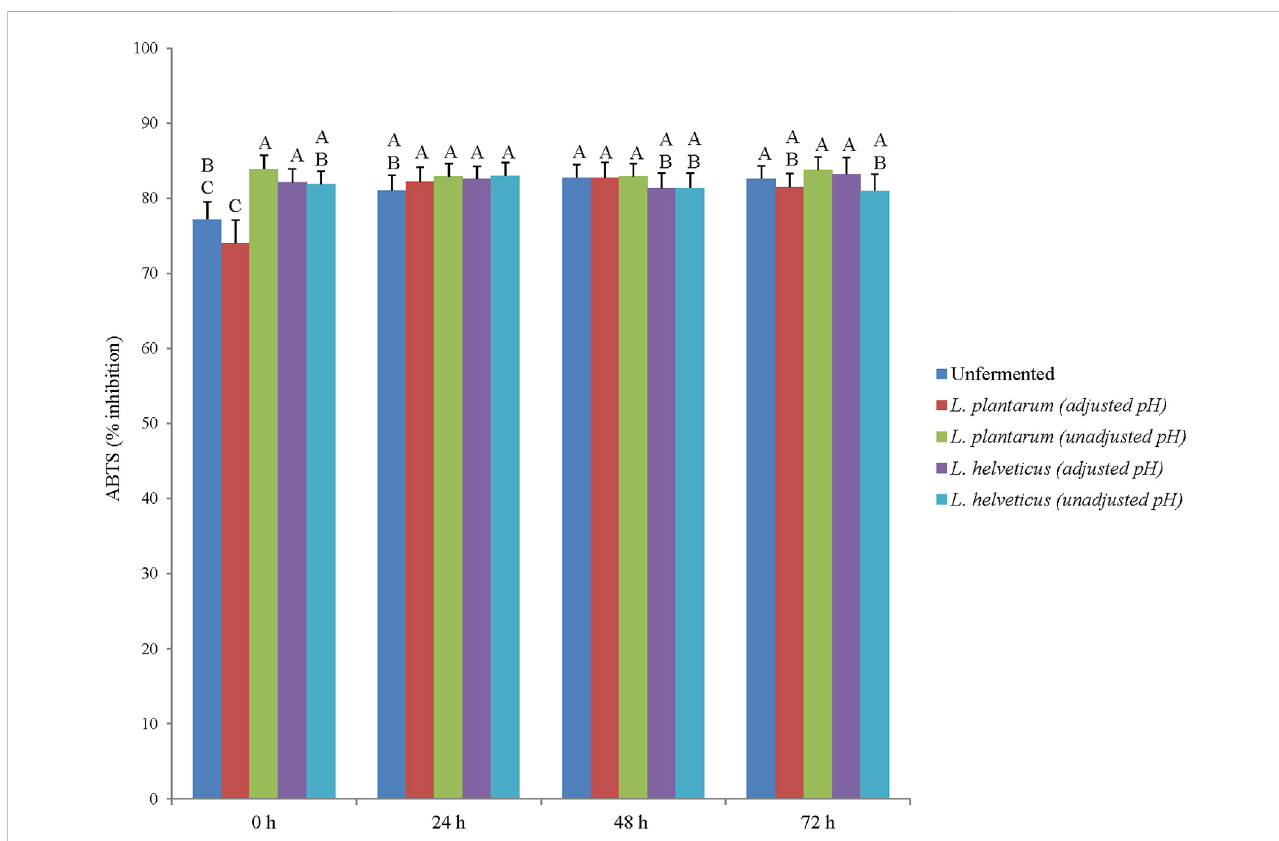
FIGURE 2 2, 2-Azino-bis-(3-ethylbenzthiazoline-6-sulfonic acid) (ABTS) scavenging activity (% inhibition). Different letter represents statistical differences in ABTS scavenging activity among the extract × fermentation time point interactions ( p <